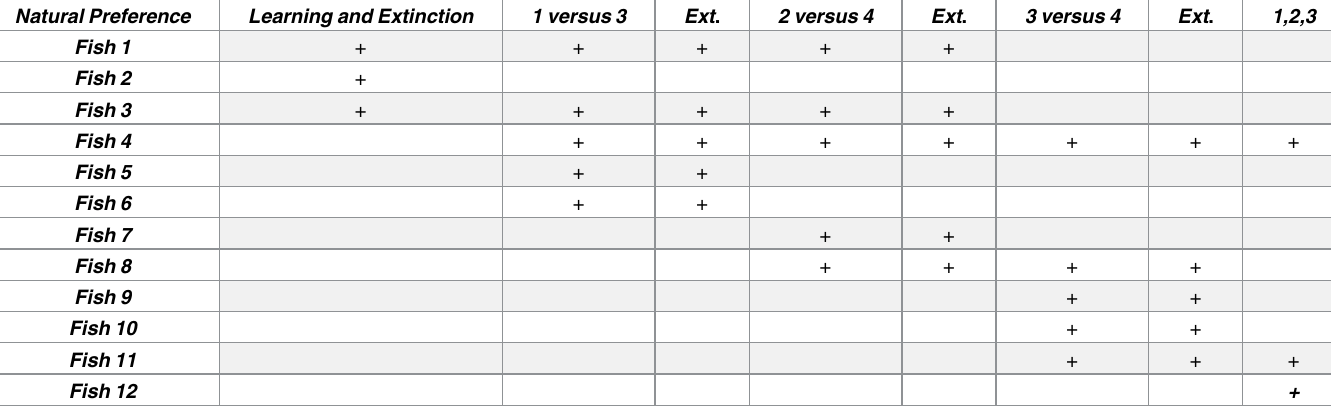
Table 1. Summaryof fish participating in different experiments. Ext. stands for “extinction”. The + sign indicatesthat the fish took part in the experiment. Natural